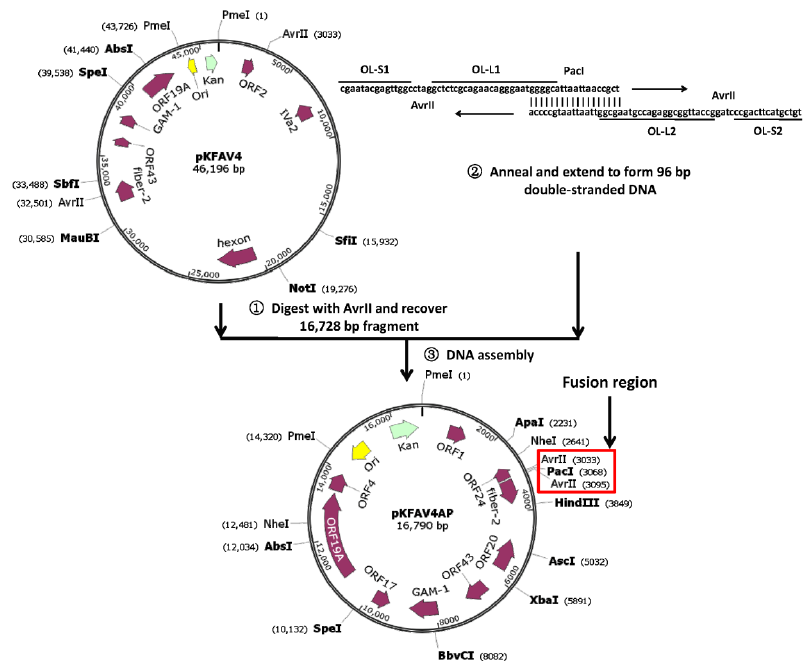
Figure 1. Schematic diagram for generating the intermediate plasmid pKFAV4AP (pKFAV4AvrII-PacI). The infectious clone pKFAV4 and pKFAV4AP composed a reverse genetics system for modification of the right end of fowl adenovirus 4 (FAdV-4): the gene mutation could be carried out in the small